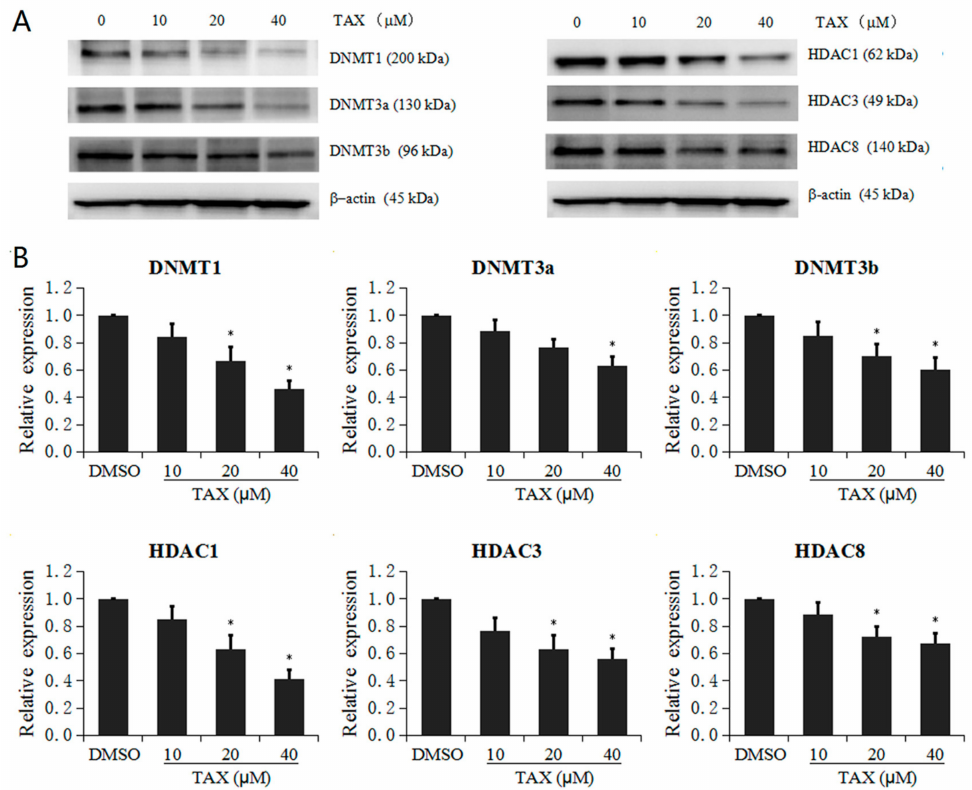
Figure 7. Effect of TAX (10 to 40 µ M) on DNA methyltransferase (DNMT) and histone deacetylase (HDAC) protein expression in JB6 P+ cells. JB6 P+ cells were treated with different TAX concentrations (10 to 40 µ M). The expression of DNMT1, 3a and 3b as well as HDAC1, 3, 4, and 8 proteins was detected by western blotting respectively. ( A ) Western blot images of DNMTs including DNMT1, 3a, and 3b, as well as HDAC1, 3, 4, and 8; ( B ) TAX significant inhibited the protein levels of DNMT1, 3a, and 3b, as well as HDAC1, 3, 4, and 8; The graphical data are represented as the mean ± SD from three independent experiments. * p < 0.05, indicating significant differences in each group compared with its level in non-TAX-treated